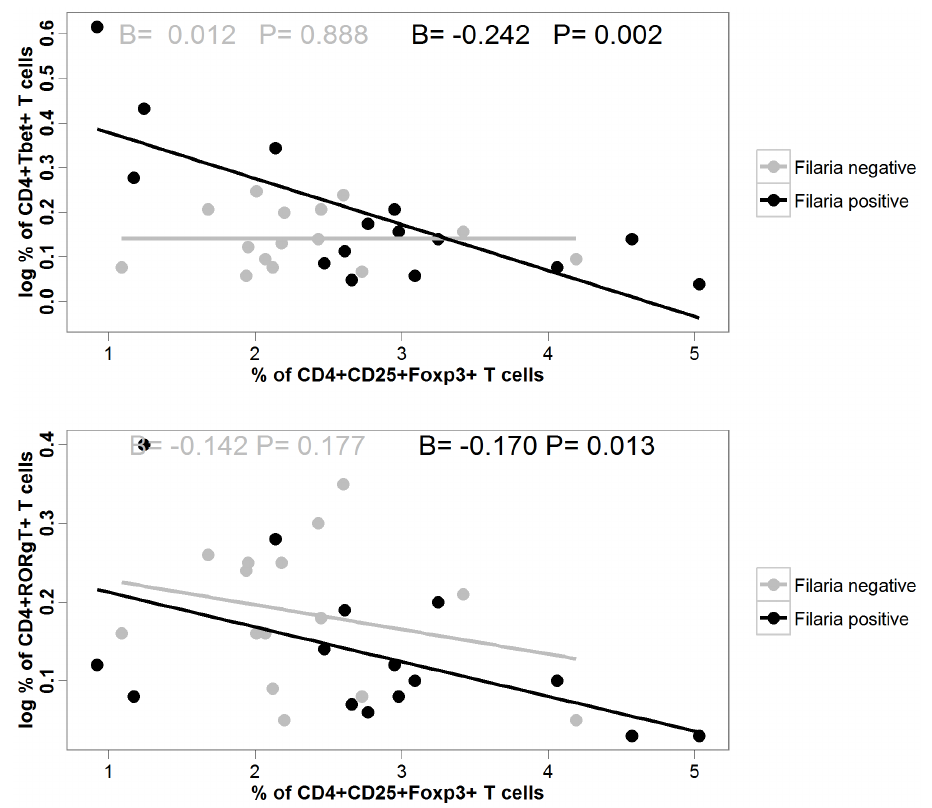
Fig. 2. The relation between CD4 + CD25 hi FOXP3 + T cells and CD4 + Tbet + (upper panel) as well as CD4 + CD25 hi FOXP3 + T cells and CD4 + ROR c T + T cells (lower panel) of CBMC of neonates from filaria negative (in grey) and filaria positive (in black) mothers assessed by a linear regression analysis. Each dot shows value from a single subject while the solid lines represent the regression lines of the model. The strength of the association between two variables is given by the value of the regression coefficient beta ( b ) value in each graph. A positive b value indicates a positive association between the variables in the model while a negative b value indicates a negative association. P values are given to indicate the statistical significance of the associations.